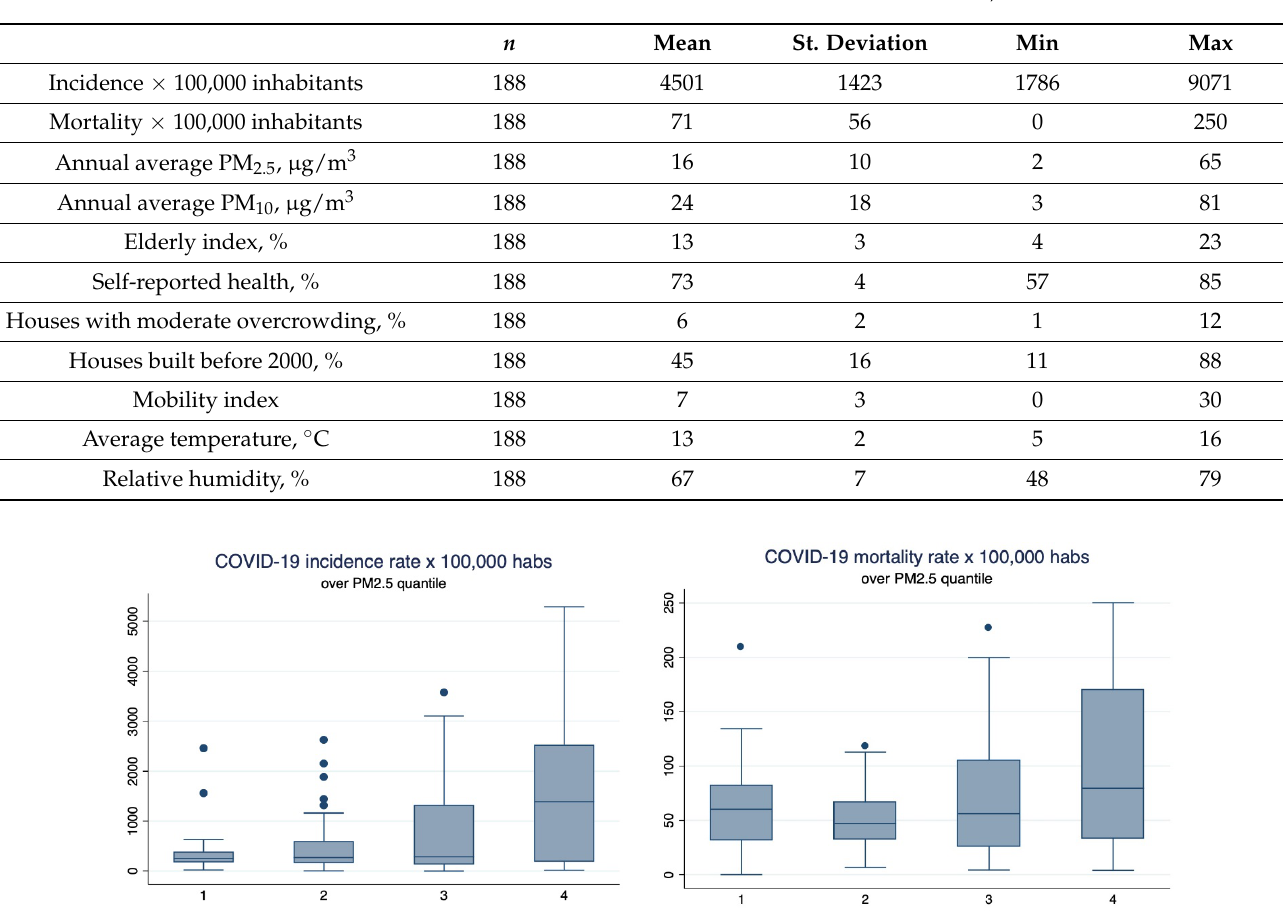
Figure 2. Spatial distribution of incidence and mortality rate, PM 10 , PM 2.5 , relative humidity, annual average temperature, elderly index, % houses built before 2000, % houses with moderate overcrowding, and mobility index. Table 1. Health and socio-environmental statistics in 188 Chilean communes, 2020.